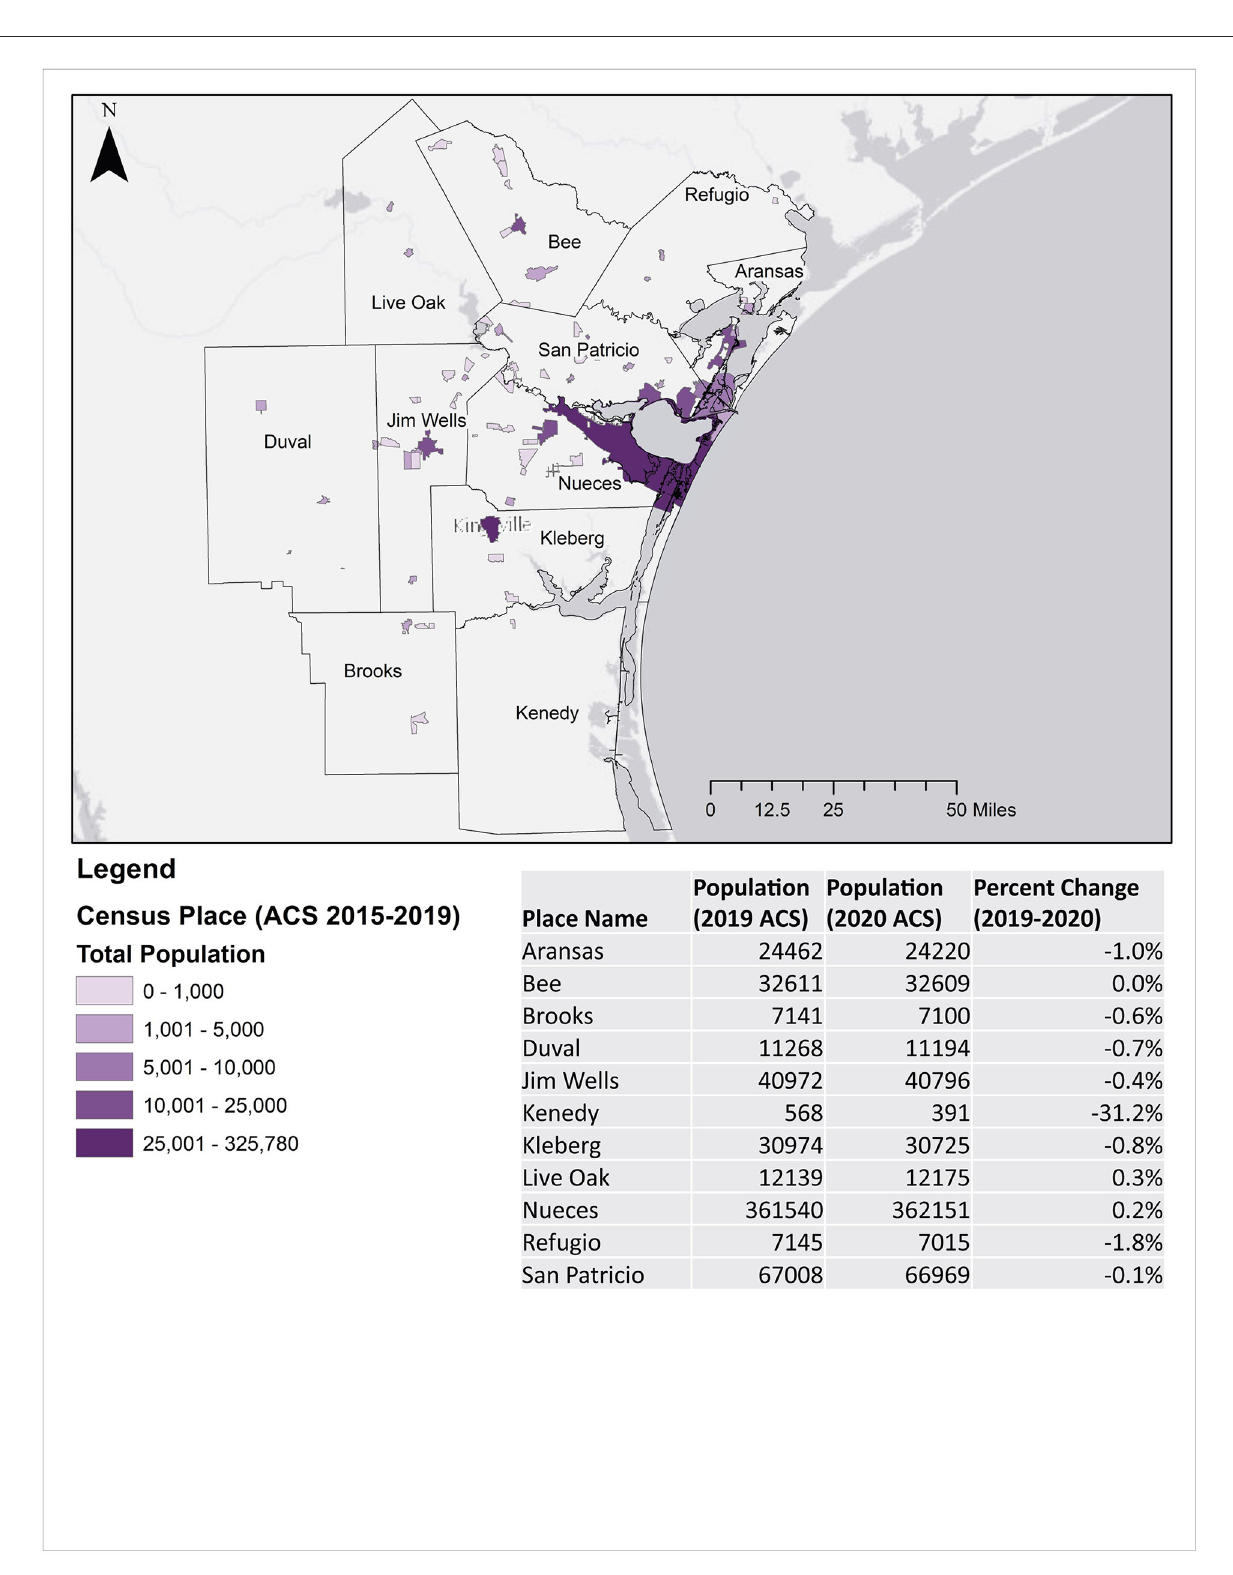
FIGURE1 Map of the Texas Coastal Bend and population (Del Angel et al., 2022).